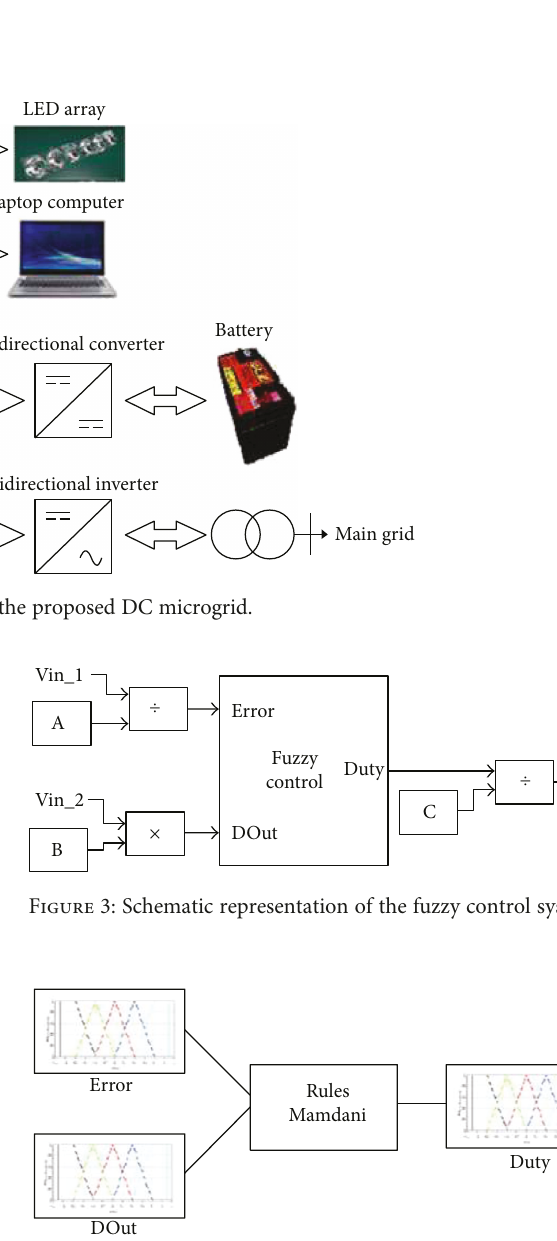
Figure 4: Schematic representation of the structure of the fuzzy